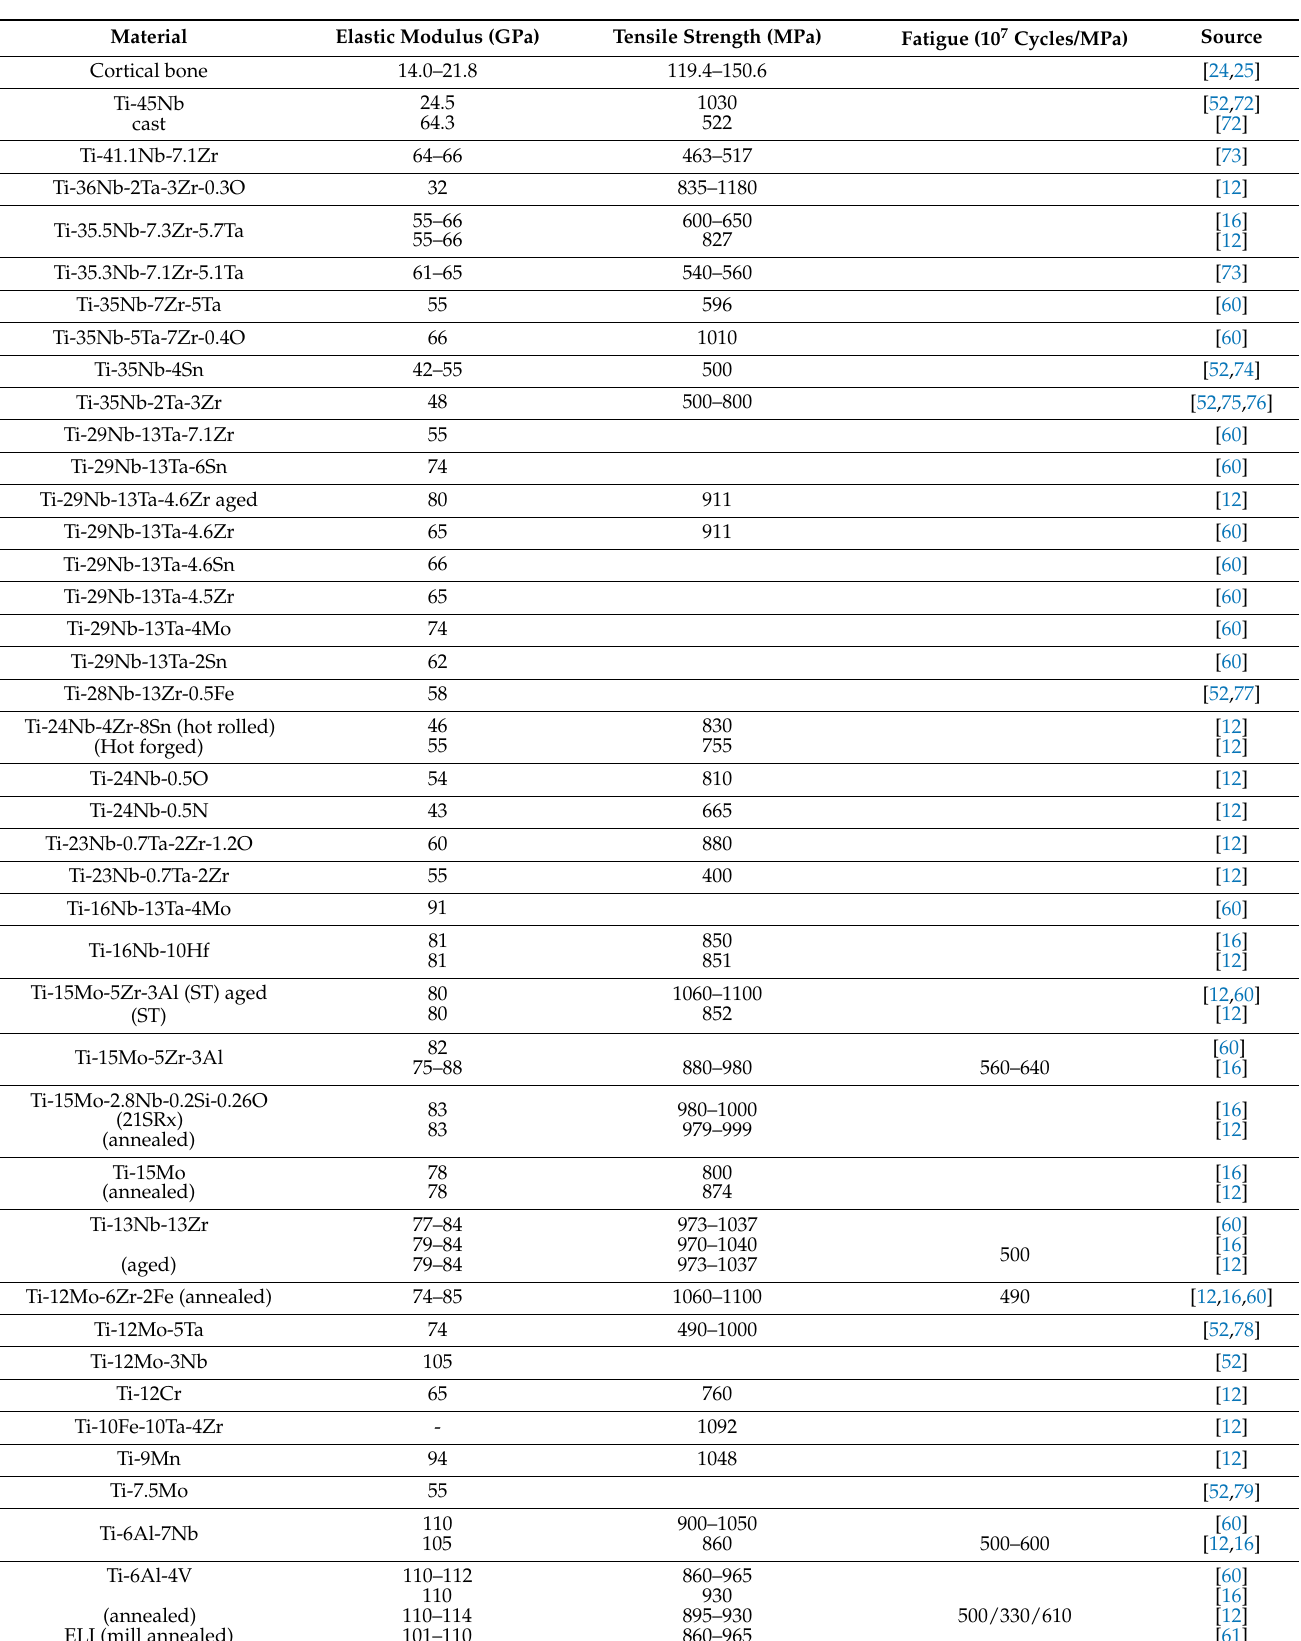
Table 4. List of